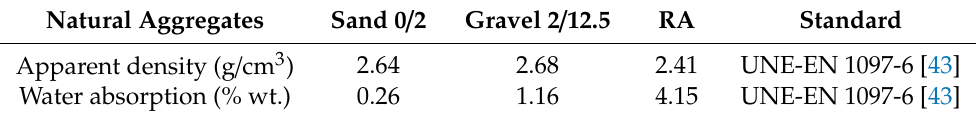
Table 3. Density and water absorption of the natural aggregates and RA.